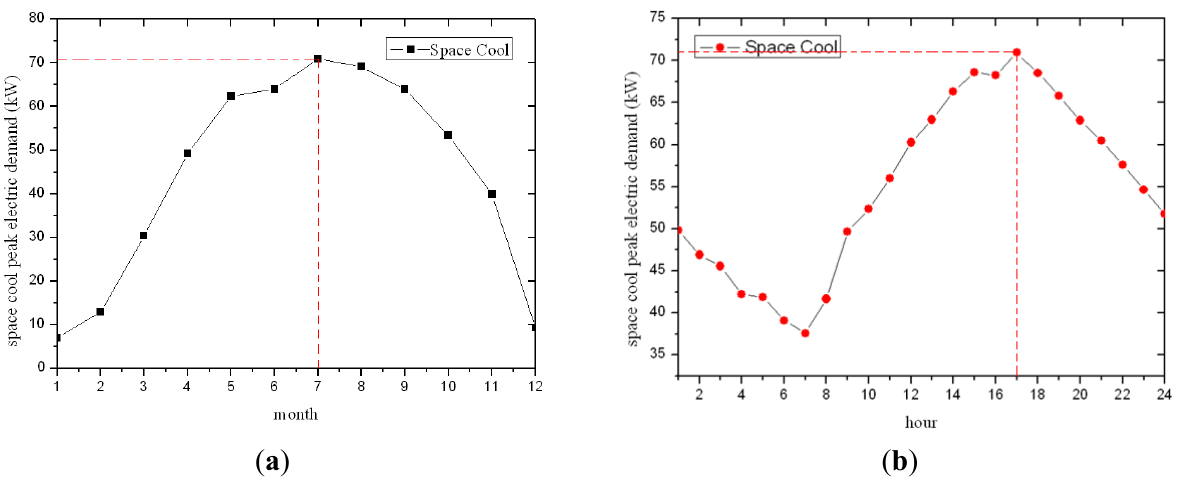
Figure 4. Cooling load simulations: ( a ) Monthly cool load and ( b ) Hourly cool load (12